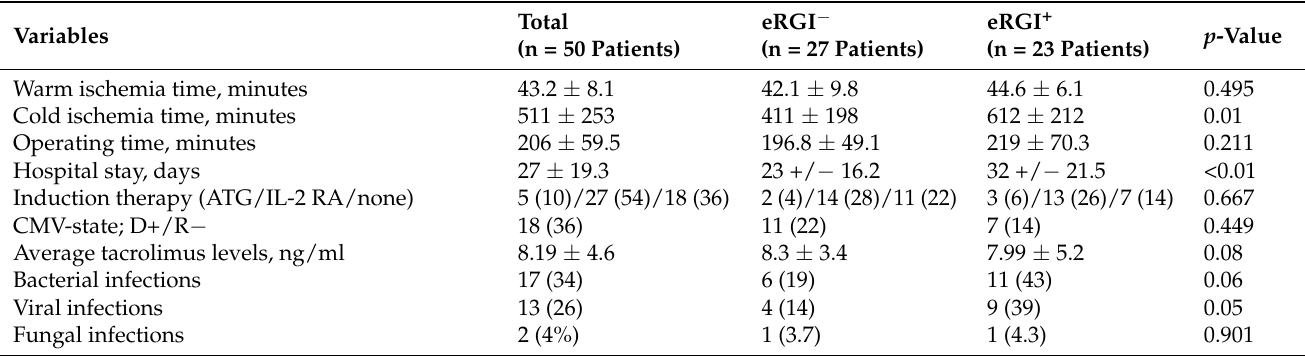
Table 2. Transplant-related and peri- and postoperative outcome for patients with early renal graft injury (eRGI) and those without, following kidney transplantation.